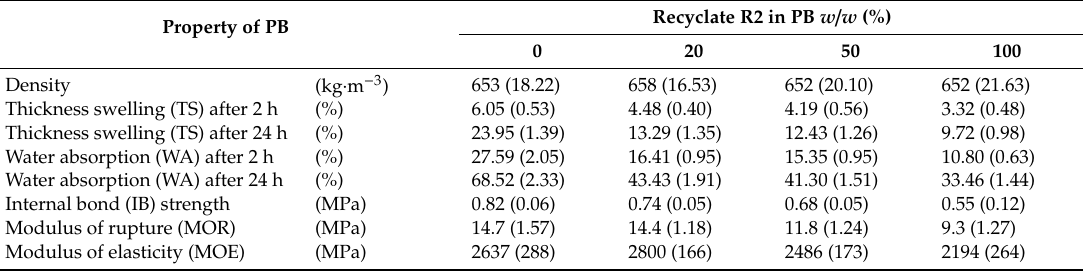
Table 4. Physical and mechanical properties of the control PB (PB-C) and of the PBs containing particles from recycled PBs—R2.